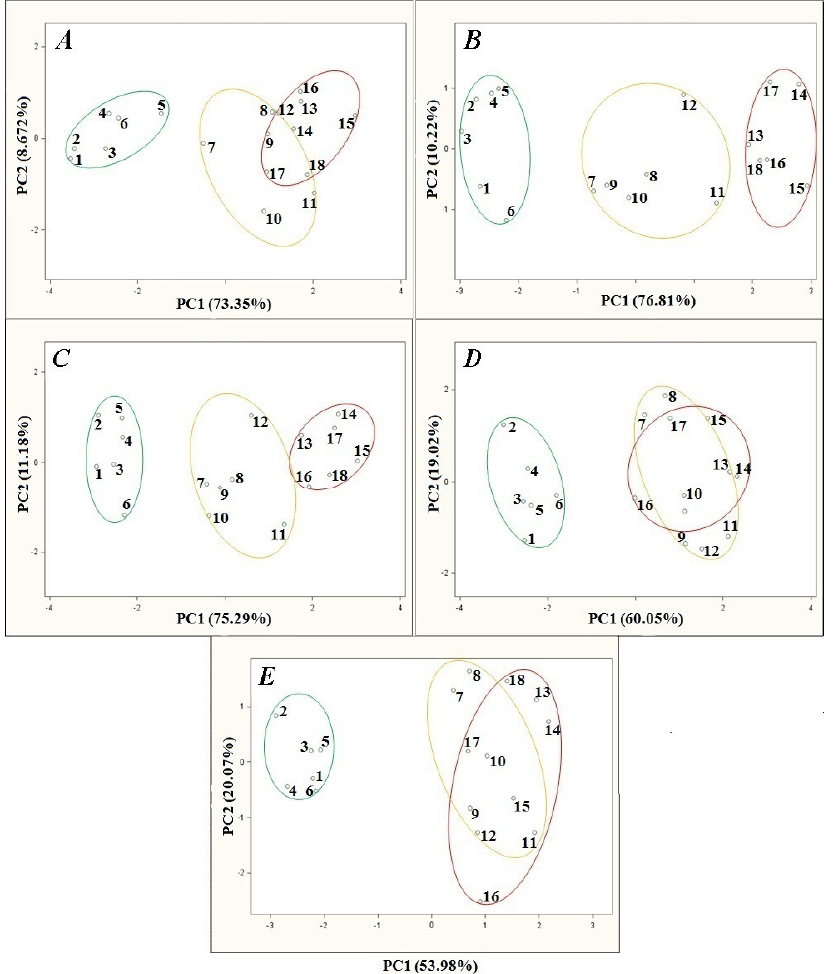
Figure 5. PCA results of samples of agricultural distillates for different time of sensor signal acquisition since barbotage process onset: ( A ) 20 s; ( B ) 60 s; ( C ) 90 s; ( D ) 120 s; ( E ) 180 s; points: 1–6—high quality class distillates (green), 7–12—medium quality class distillates (yellow), 13–18—low quality class distillates